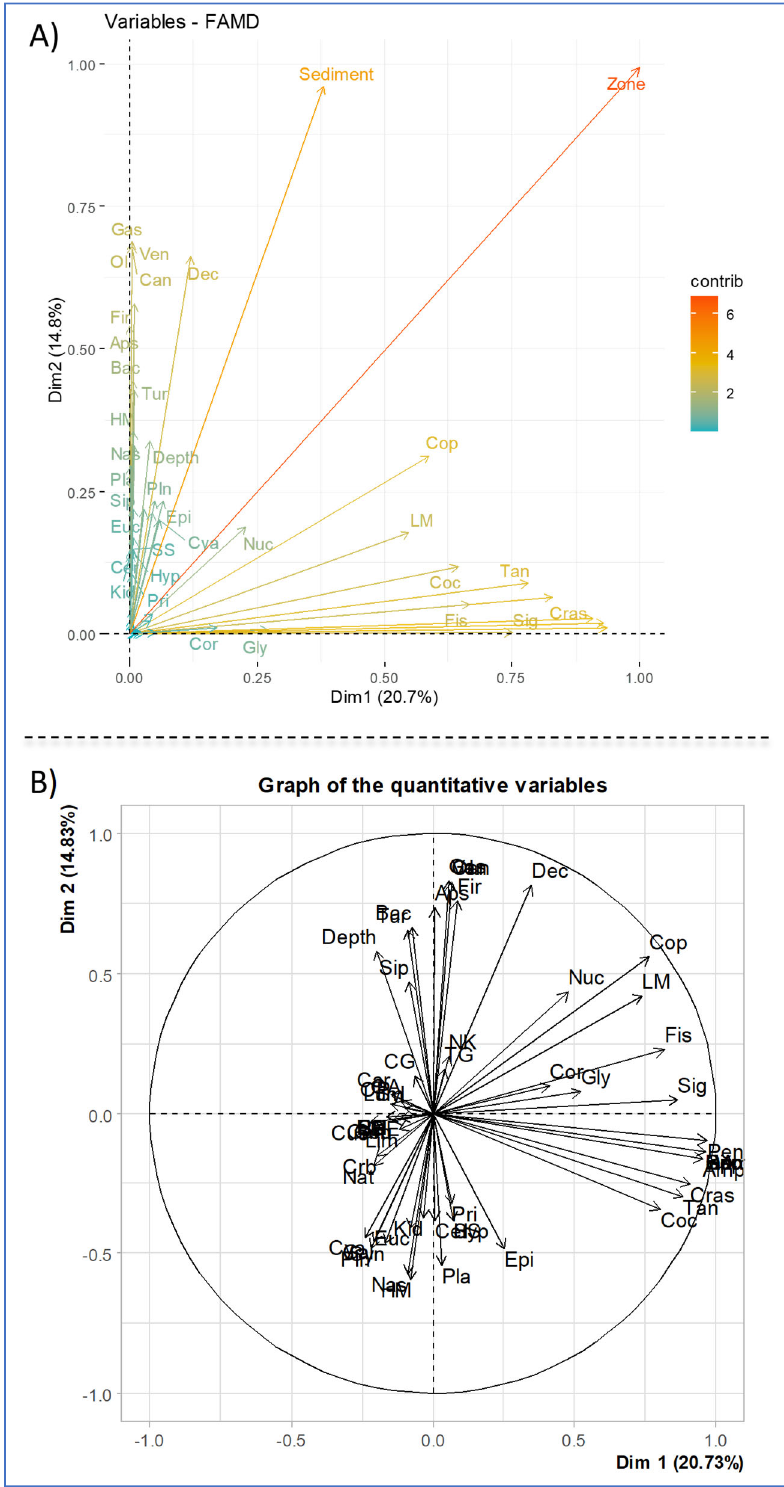
Figure 8. ( A ) Factorial analysis for mixed data (FAMD) showing the distribution of the species in relation to sediment type, station depth, and estuarine zone, and ( B ) correlation circle .